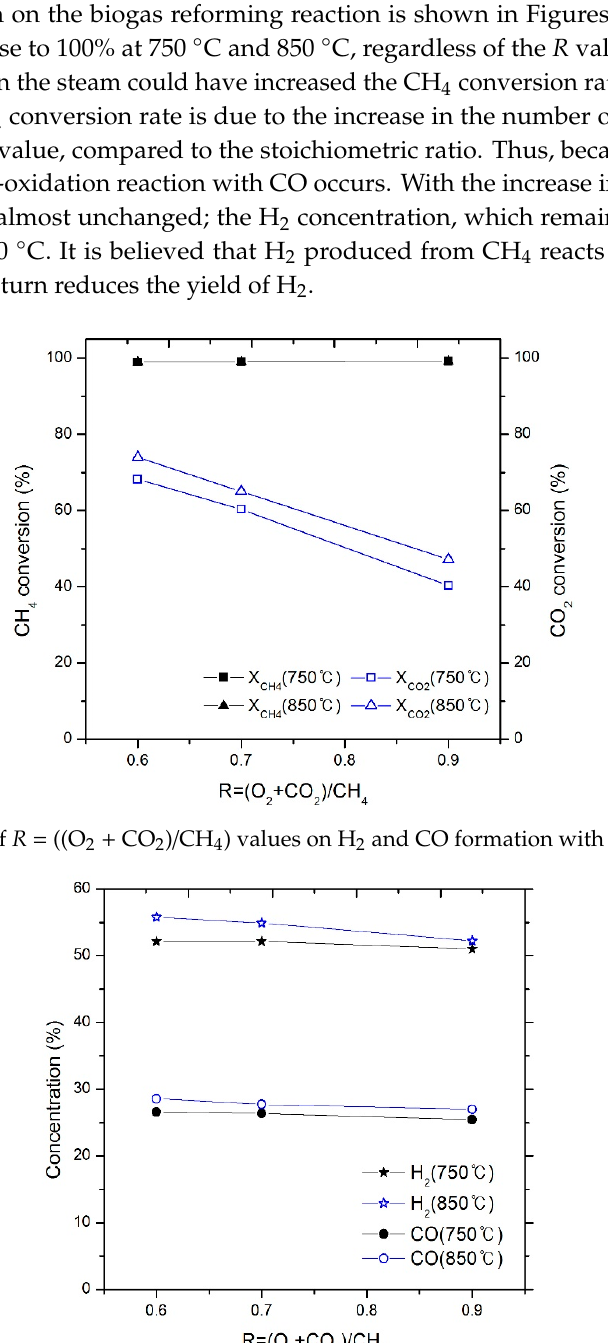
Figure 10. Effect of R = ((O 2 + CO 2 )/CH 4 ) values on syngas yield.